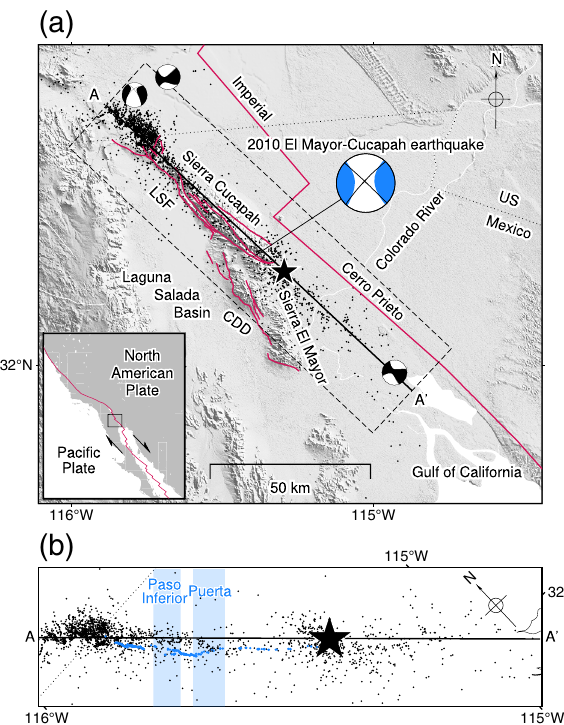
Figure 1. ( a ) Seismotectonic map of the study region. The blue and black beachballs indicate the GCMT solutions 10,11 for the mainshock and 3-day aftershocks, respectively. The A–A ′ line corresponds to the top of the model plane used for our optimum finite-fault solution. The star shows the epicentre of the 2010 El Mayor- Cucapah earthquake. Red lines indicate the plate-boundary fault 16 and the Laguna Salada fault (LSF)–Cañada David detachment (CDD) fault system 17 . The inset shows the regional tectonic setting, and the dashed rectangle shows the area shown in ( b ). ( b ) Seismotectonic map of the area along A–A ′ . Blue dots represent surface faults 12 . Blue-shading highlights the Paso Inferior and Puerta accommodation zones 12 . The star is the relocated epicentre 13 . Black dots show relocated 3-day aftershocks 13 . The dotted line shows the U.S.–Mexico border. This figure was made with Generic Mapping Tools (v6.2.0) 18 and the background topography in ( a ) is based on SRTMGL3 data 19